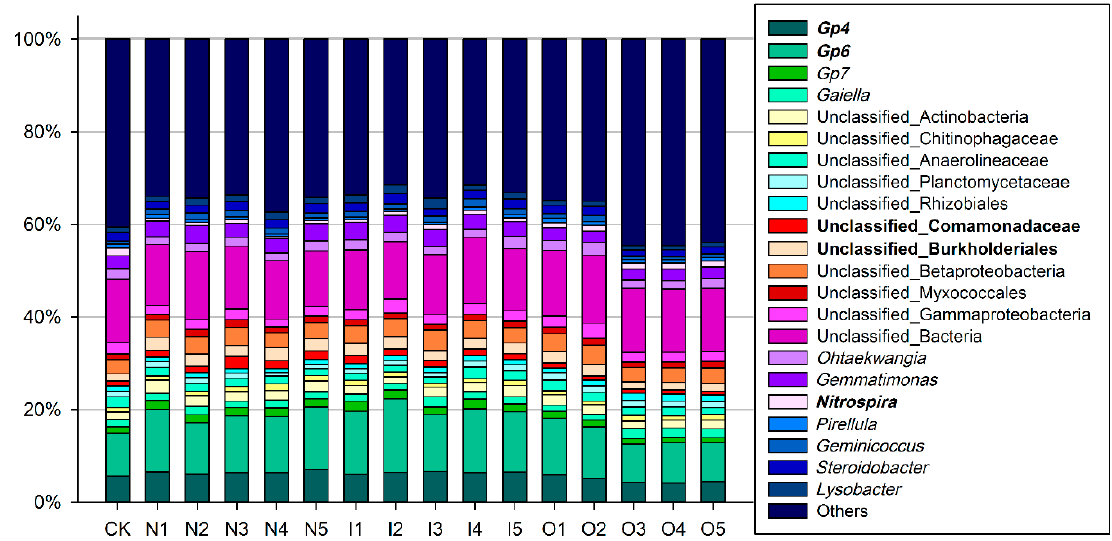
Figure 3. Relative abundance stacked bar plot of the microbial genera. The samples were summarized by management ‐ plant types.